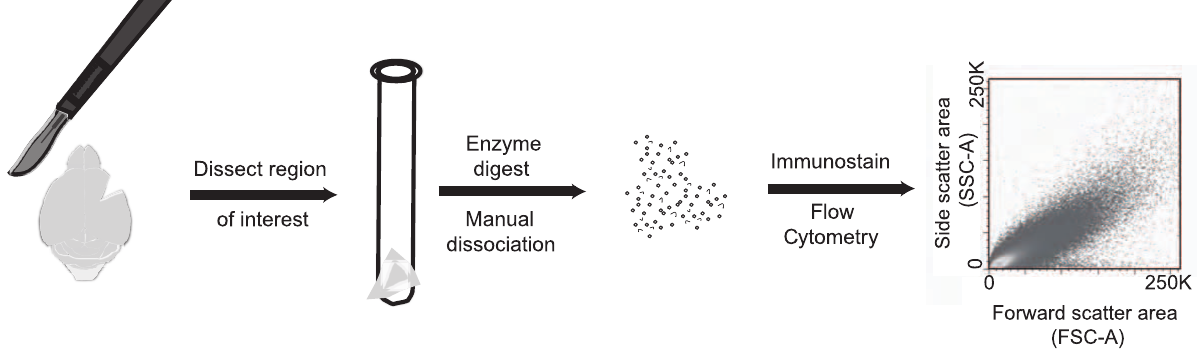
Figure 1. Schematic of flow cytometry protocol. Specific brain regions are microdisected, enzymatically digested, and dissociated via trituration. Subsequently, dissociated cells are immunostained with anti-AcH3 antibody, labeled with diamidino-2-phenylindole (DAPI) dye to identify stained nuclei, and run on a flow cytometer. Levels of AcH3 are measured as the median fluorescence intensity of DAPI-positive events.